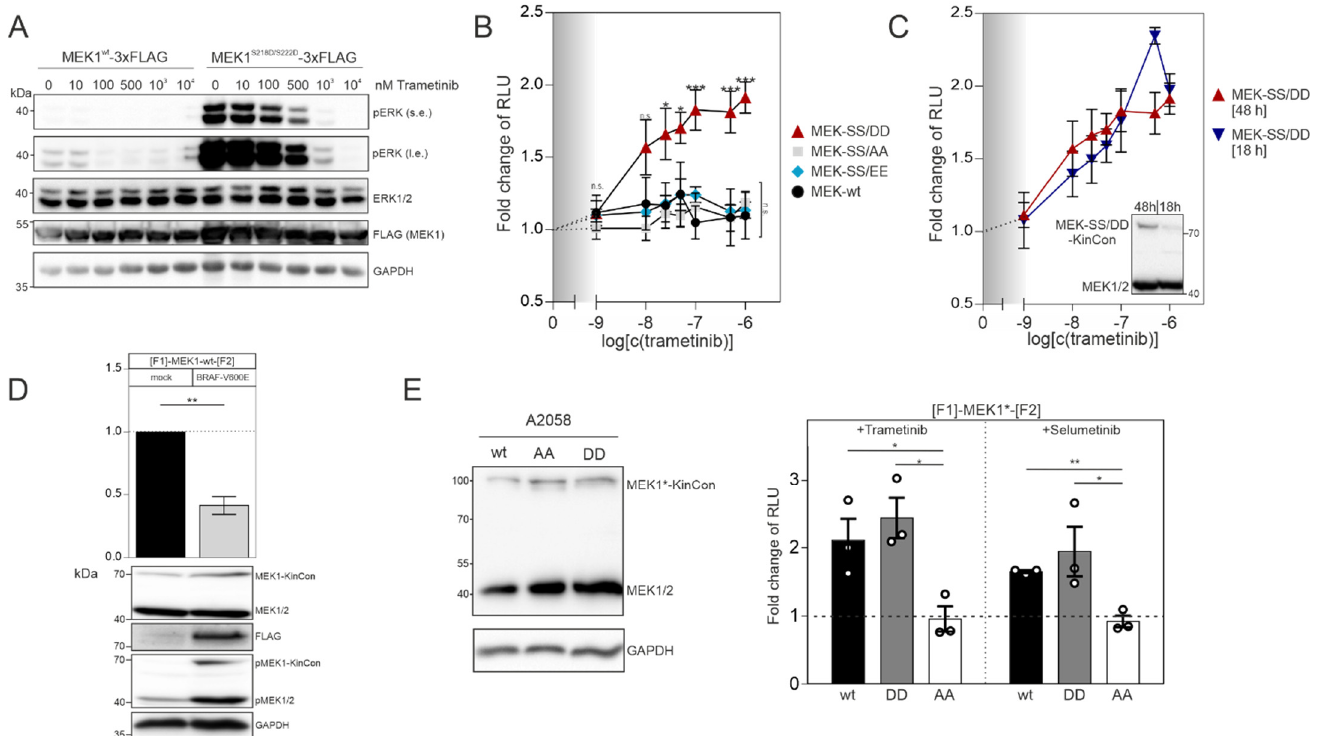
Figure 2. MEKi and BRAF activities affect MEK1 KinCon reporter dynamics: ( A ) ERK1/2 activation following overexpression of indicated MEK1 fusion proteins and exposure to increasing doses of the MEKi trametinib for 1 h. Shown is a representative Western blot of n = 4 independent experiments. Antibodies directed against phosphorylated ERK (pERK, either short exposure (s.e.) or long exposure (l.e.)), total ERK1/2, flag or GAPDH as loading control were used (HEK293T). ( B ) Dose-dependent effect of 1 h trametinib treatment on the dynamics of indicated MEK1 KinCon reporters. Data points represent obtained bioluminescence signals in RLU relative to the DMSO control. They were plotted against increasing inhibitor concentrations on a logarithmic scale ( ± SEM from n = 8 independent experiments, HEK293T). ( C ) Shown are the dose-dependent responses of trametinib exposure upon expression of the MEK1 KinCons for 18 h ( n = 3) versus 48 h ( n = 8) (HEK293T). ( D ) Bars represent obtained bioluminescence signals in RLU relative to the signals of the MEK1 KinCon reporter in the presence of overexpressed and flag-tagged BRAF-V600E ( ± SEM from n = 5 independent experiments; normalized on KinCon reporter expression levels). Antibodies directed against phosphorylated MEK1/2, total MEK1/2, flag and GAPDH were used (HEK293T). ( E ) A2058 transiently expressing indicated KinCons were subjected to MEKi exposure with 1 µ M trametinib, selumetinib or DMSO for 1 h. Bioluminescence signals in relative light units (RLU) relative to the signals of the DMSO treatment are depicted ( ± SEM from n = 3 independent experiments). Student’s t -test was used to evaluate statistical significance. Confidence level is indicated by asterisk as: * p < 0.05, ** p < 0.01, *** p <